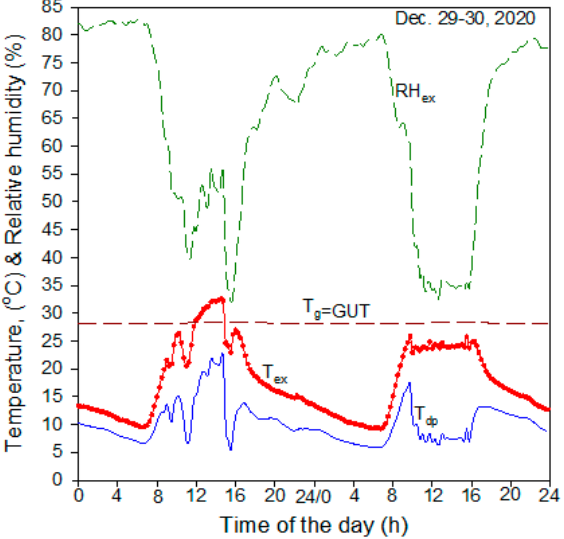
Figure 7. Diurnal variation in estimated dew-point temperature ( T dp ) of air ventilated from a greenhouse at T ex and RH ex and flowed through EAHE pipes buried at the GUT in winter season (29–30